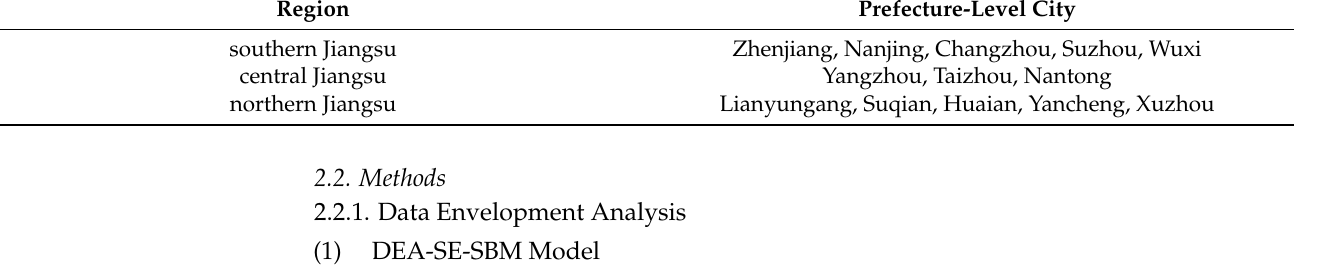
Figure 1. Distribution map of southern, central, and northern regions in Jiangsu Province. Table 1. Distribution of prefecture-level cities in the three regions of Jiangsu Province. Region